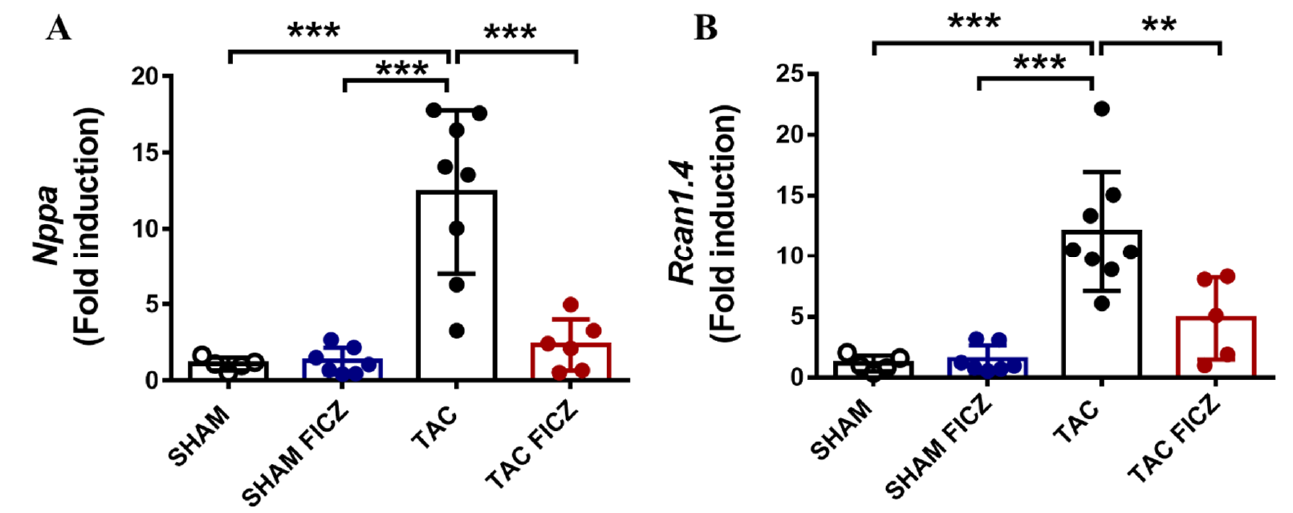
Figure 4. FICZ treatment prevents hypertrophic development by attenuating the calcineurin/RCAN1.4 pathway in mice subjected to TAC surgery. Real-time PCR analysis of mRNA expression of the cardiac hypertrophy biomarker atrial natriuretic peptide ( Nppa ) ( A ) and Rcan1.4 ( B ). Expression was normalized to that of the Rplp0 housekeeping gene. Groups are: Sham (open circles) ( N = 5), Sham FICZ (blue circles) ( N = 7), TAC (black circles) ( N = 8) and TAC FICZ (red circles) ( N = 6). Data are expressed as mean ± SD. ** p < 0.01; *** p < 0.001.